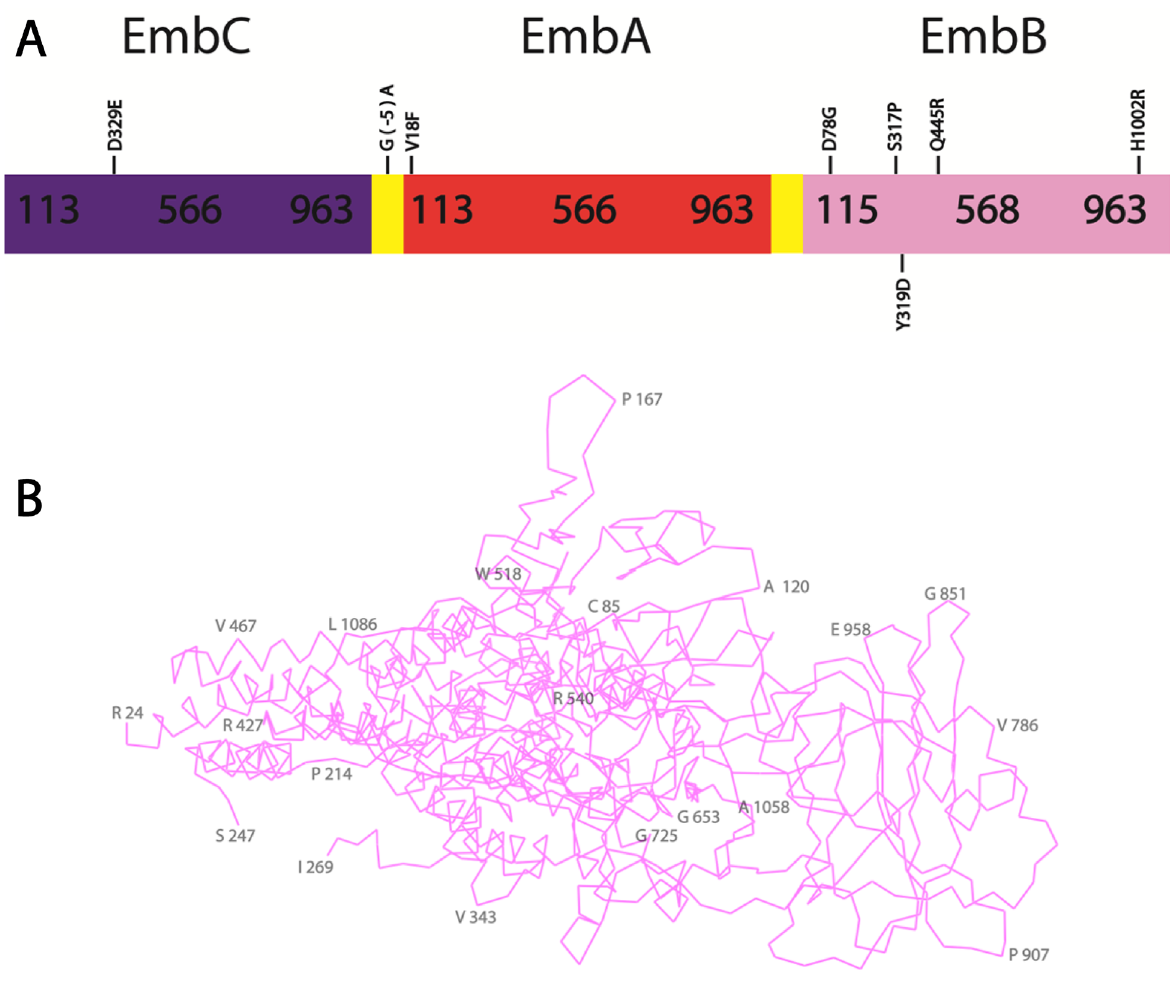
Figure 7 - Structure and key mutations involved in the embCAB operon and their proteins, which are involved with EMB resistance. A - Representation of embCAB operon and the position of mutations involved in the resistance to EMB. The EmbC, EmbA and EmbB sequences are represented in purple, red and pink, respectively, showing the mutations described herein. The intergenic spaces between the gene encoding regions are shown in yellow. B – EmbB Structure. The Cα contours are shown in pink. EmbB structure was obtained from PDB entry 7BVF (Zhang et al ., 2020) and the figure was prepared using the software PyMOL (Schrödinger, 2015). A number of residues are numbered in 50% opacity for better